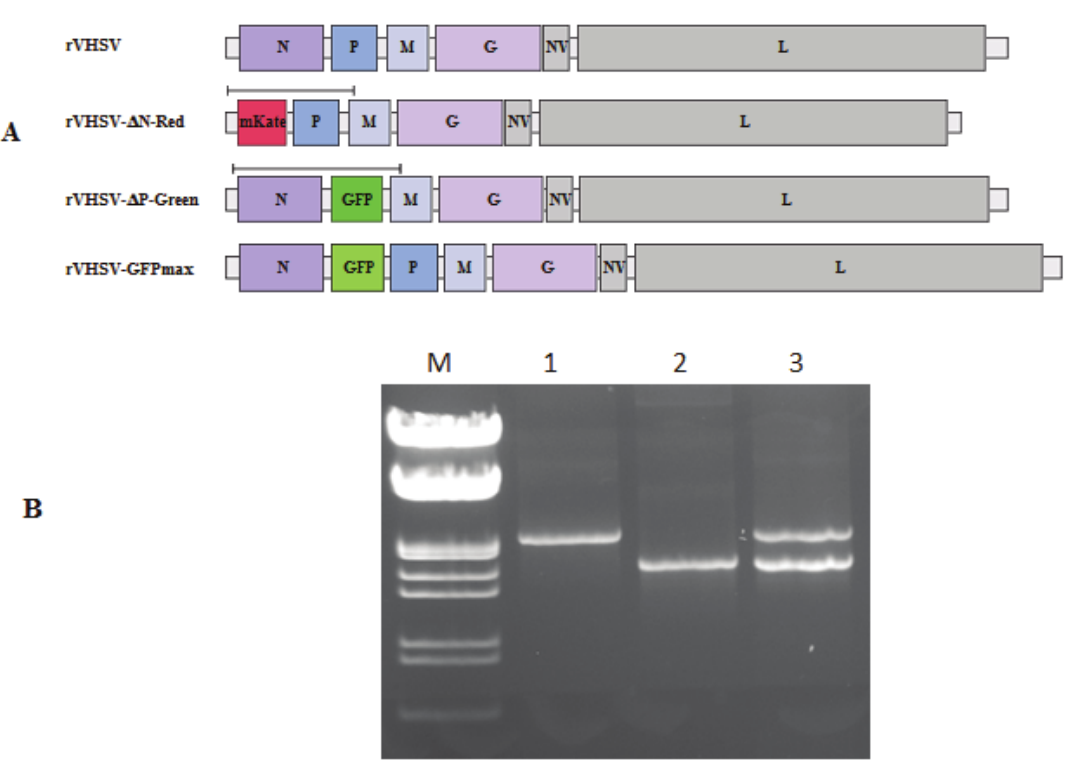
Figure 2. Schematic representation of the various recombinant VHSV genomes and RT-PCR products analysis. A schematic representation of rVHSV, rVHSV- Δ N-Red (mKate), rVHSV- Δ P-Green (GFP) or rVHSV-GFP genomes is shown. Part of the genomes containing mKate or GFP genes was amplified through RT-PCR with specific primers (Table 1). The black line above the genomes indicates the parts of the genomes amplified ( A ). Agarose gel analysis of the PCR or RT-PCR products amplified from either the plasmid constructs pVHSV- Δ P-Green (1) and pVHSV- Δ N-Red (2) or from supernatant of yellow infected-cell foci (3), respectively ( B ). M: DNA molecular weight marker (ThermoFisher scientific).